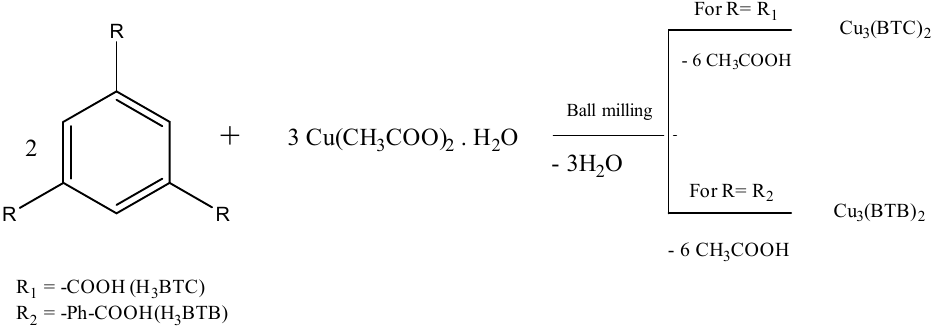
Figure 4. Schematic experimental representation of the mechanochemical nanocasting of porous metal oxides (Panel [ A ]) (reproduced with the permission from Ref. [63], Published Copyright © 2018 American Chemical Society) and TEM images ( a – d ) representing different ratios (0.4, 0.6) of Pluronic F127 and tannin to form OMC with different magnifications and STEM-HAADF (high angle angular dark field). Images ( e – h ) representing F127: tannin (0.8) where orange circular rings show cylindrical mesopores, ( i ) represents the OMC structure obtained by using P123 Pluronic bock copolymer as a soft template (Panel [ B ]). (Reproduced with the permission from Ref. [109]. Adapted from Pengfei Zhang et al. (2017) under the Creative Commons CC BY license.)